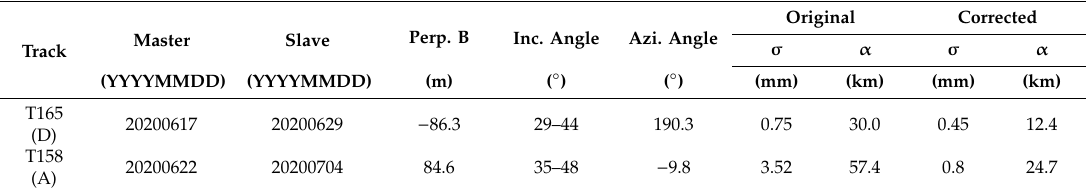
Table 1. Interferometry pairs used in this study.